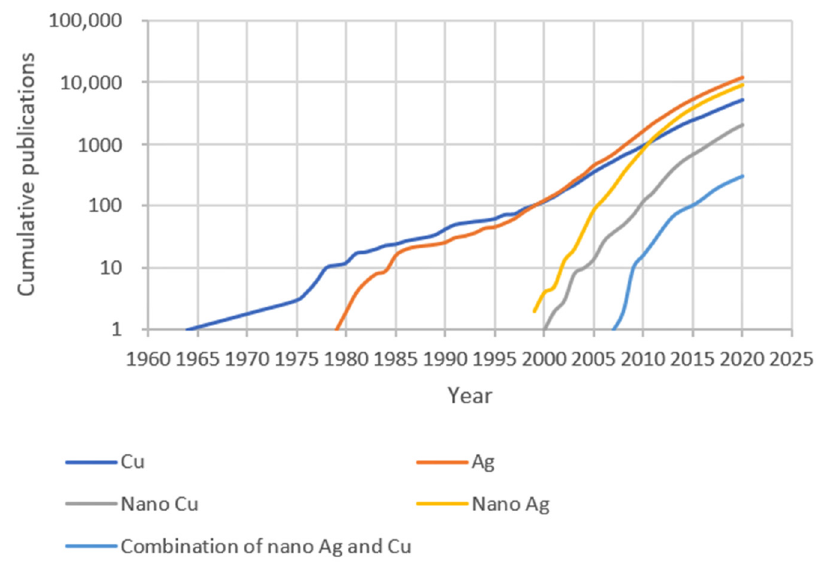
Figure 1. Cumulative numbers of publications on antimicrobial Cu and Ag, as of 1 December 2020. The bibliometric data were searched in the Polytechnique Montréal library Compendex database, as indicated in the Appendix A.